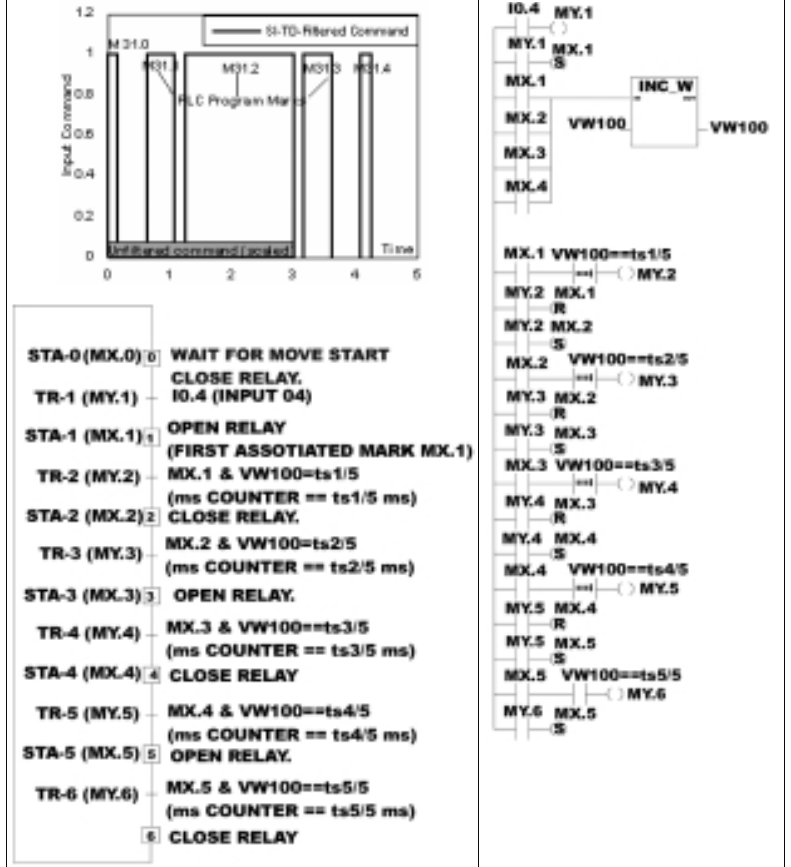
Fig. 13. (a) Petri Network designed for the filtering process. (b) Relay ladder program corresponding to the Petri Network for the temporized interrupt routine.